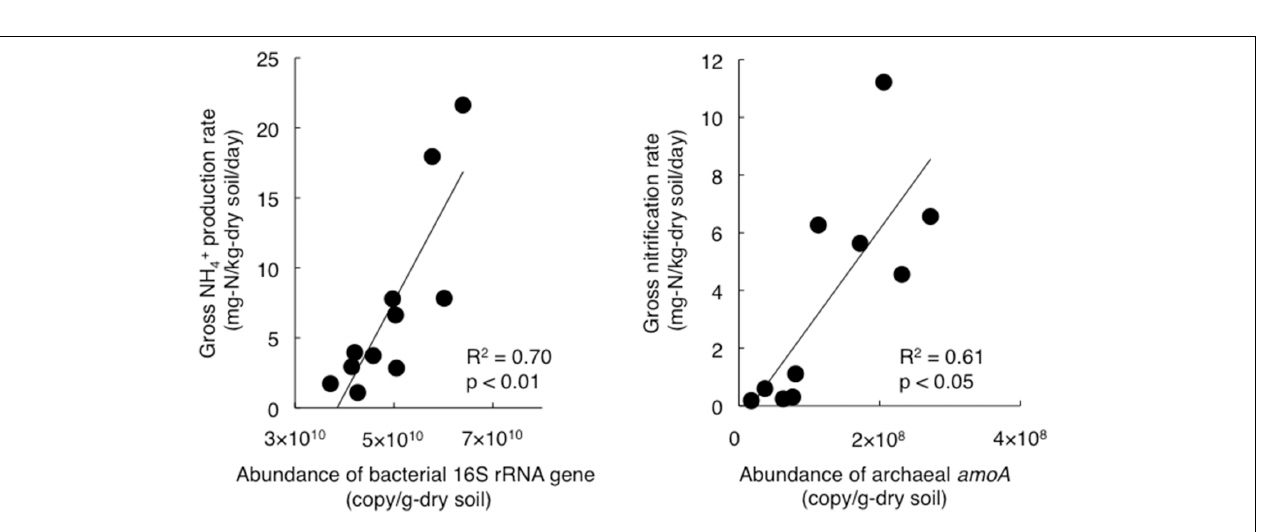
production and nitrification, abundance of bacterial 16S rRNA gene and archaeal amoA , or 4